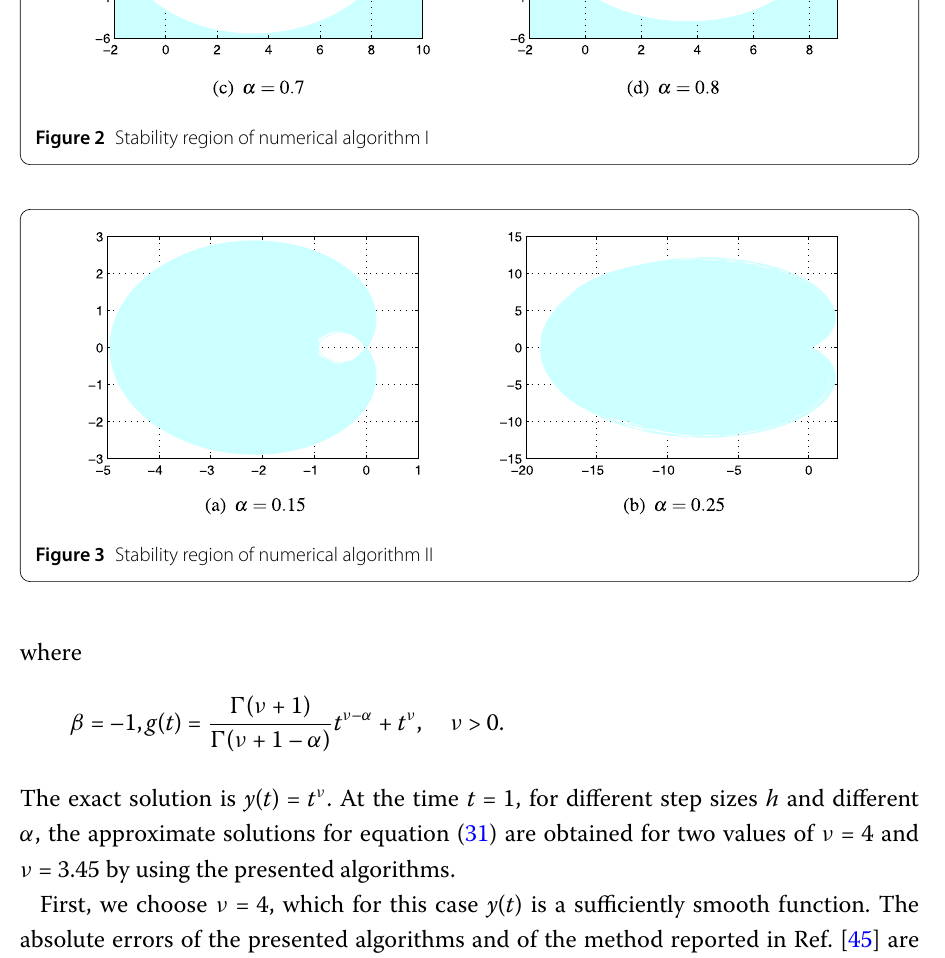
Figure 2 Stability region of numerical algorithm I